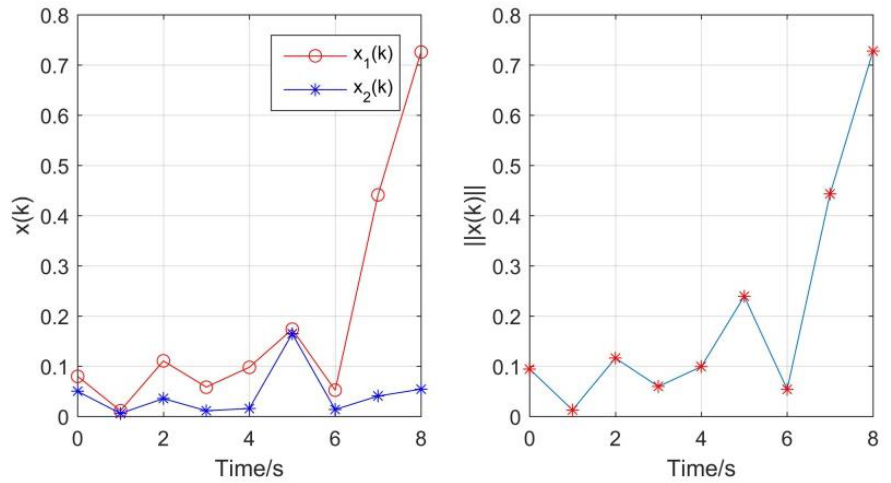
Figure 6. State trajectories of x ( k ) ( left ) and trajectories of (cid:107) x ( k ) (cid:107) ( right ).